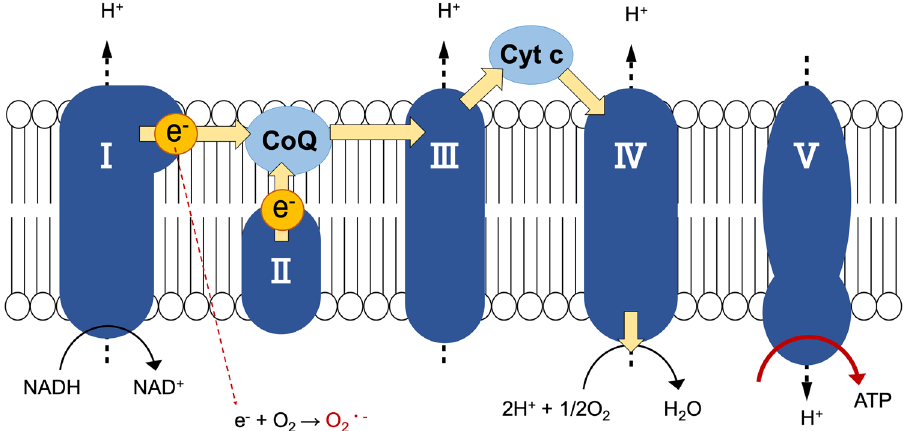
Figure 1. Mitochondrial respiratory chain complexes. Respiratory chain complexes I–IV generate a proton gradient on the mitochondrial inner membrane that facilitates ATP production by complex V (ATP synthase). The electron (e − ) passes through complex I and complex II, respectively, and moves to complex III via the CoQ. Cytochrome c (Cyt c) transfers an electron from complex III to complex IV, which reduces O 2 to form H 2 O. Electron flow involves proton (H + ) transfer across the mitochondrial inner membrane at complexes I, III, and IV, creating an electrochemical gradient. Complex V uses the proton motive force to generate